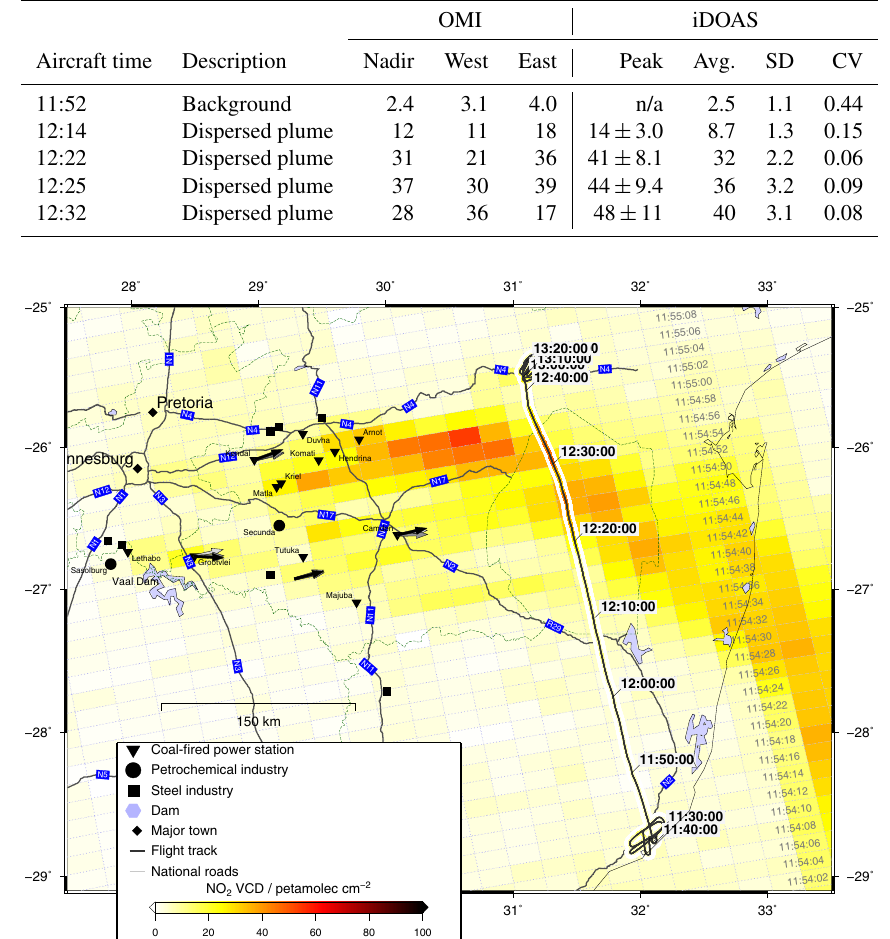
Table 3. Cases of background and plume measurements identified from the iDOAS measurements on 11 August 2007. Aircraft time is given in UTC. OMI nadir refers to the TVCD value in the OMI pixel at aircraft nadir. Similarly, OMI east and OMI west refer to the OMI pixel one row east and west of aircraft nadir respectively. iDOAS peak refers to the peak VCD within the OMI pixel at aircraft nadir. iDOAS average is the line-averaged iDOAS measurements within the OMI pixel at aircraft nadir, and iDOAS standard deviation is the iDOAS-measured variability within this OMI pixel expressed as a standard deviation. iDOAS CV is the coefficient of variation (or relative standard deviation) of the measured variability. All column densities are expressed in petamoleccm − 2 .